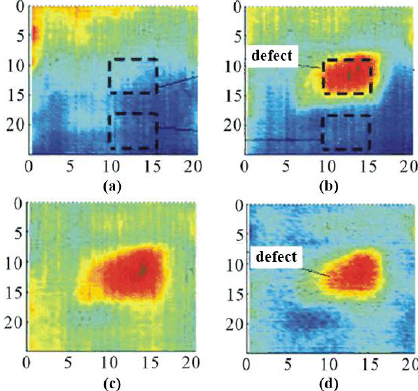
Figure 15. MWT results for the absence of adhesive in CFRP: the thermogram of the sample without defect ( a ), the thermogram of the sample with the defect ( b ), the subtraction between the thermograms of the sample with and without the defect ( c ), thermogram subtracted from its initial thermogram ( d ) [56]. Reprinted/reproduced with permission from Scientific Research Publishing Inc.